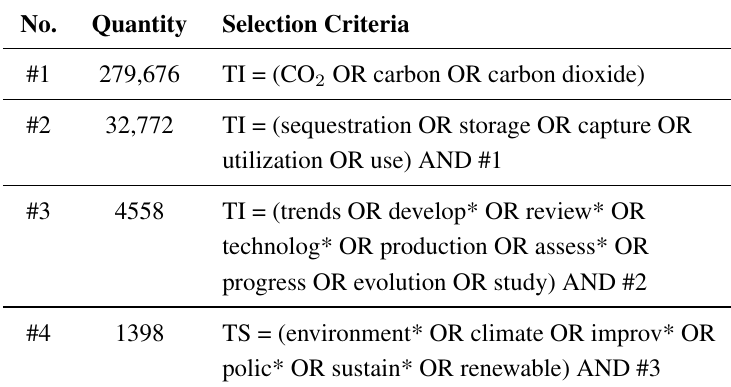
Table 2. Selection criteria for carbon research.